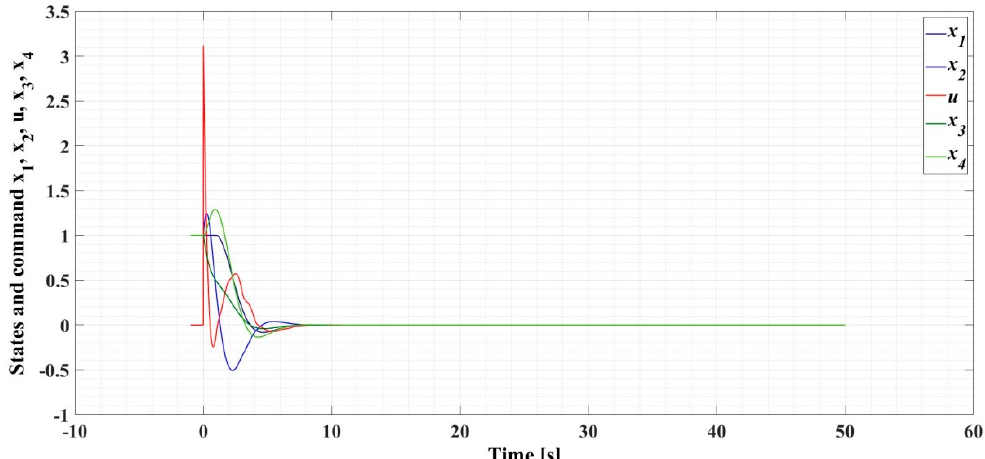
Figure 10. Evolution of the states without input saturation.